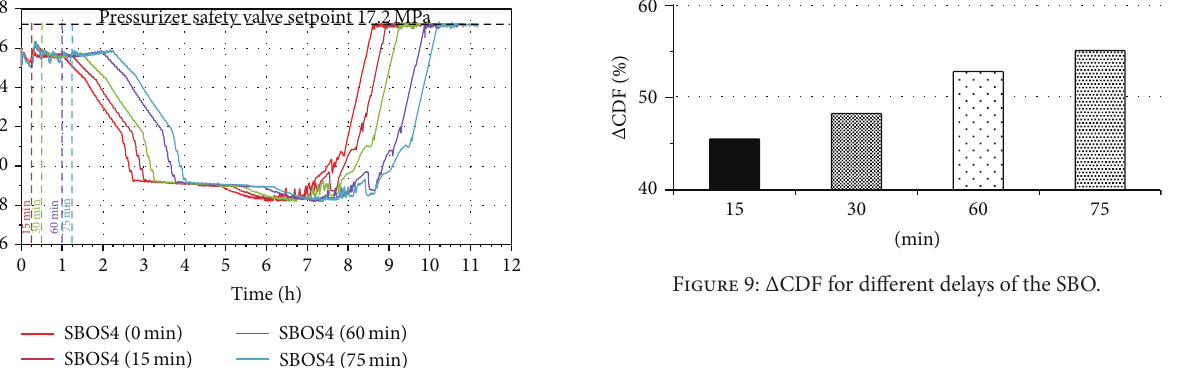
Table 6: Probability of nonrecovery of AC power within given